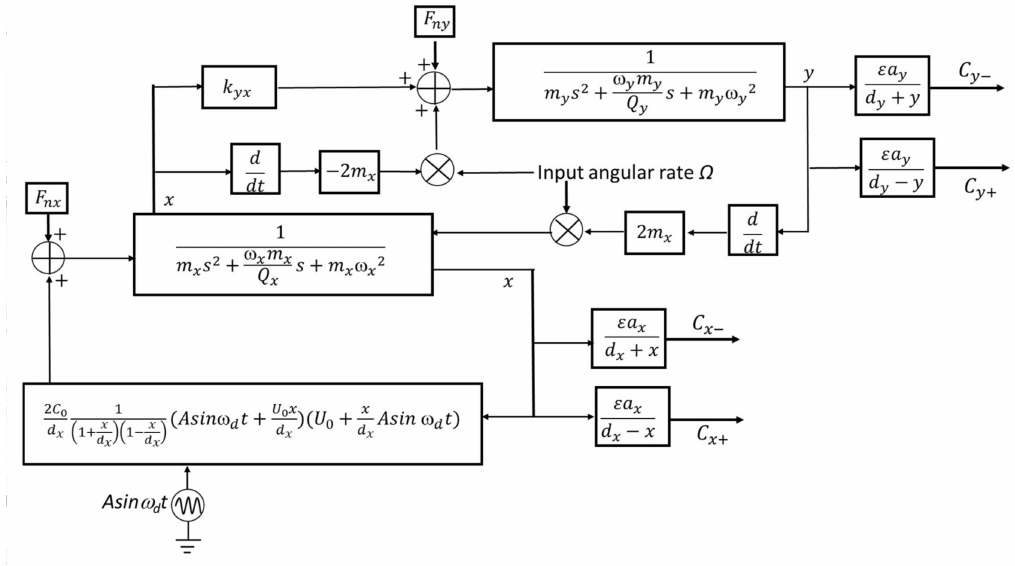
Figure 3. The PSPICE device model of capacitive